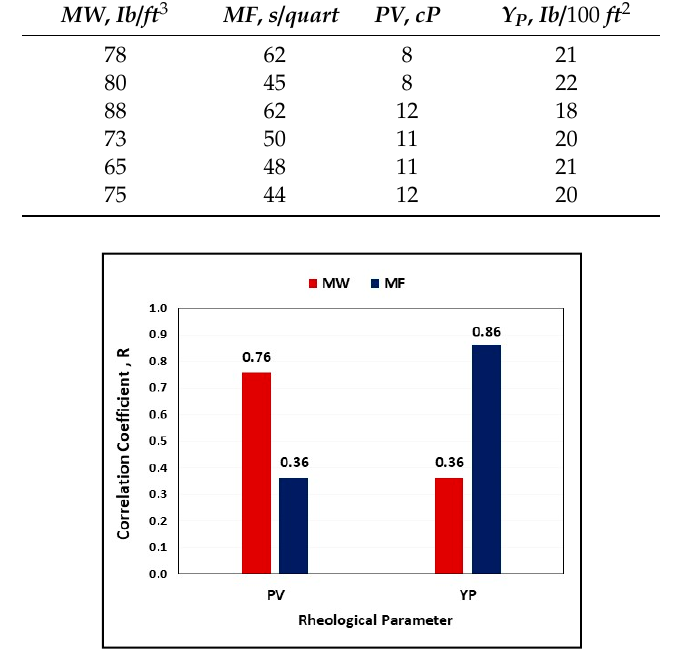
Figure 1. The relative importance of MW and MF with the rheological properties ( Y P and PV ) of CaCL 2 brine-based mud in terms of the correlation coefficient, R. Table 2. Statistical Analysis of the CaCl 2 brine-based mud collected data.